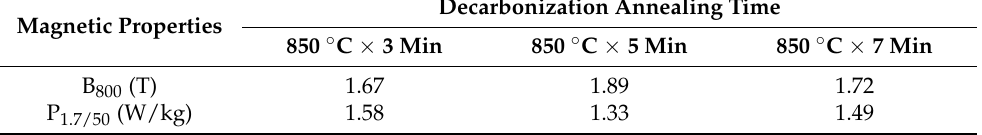
Table 4. Magnetic properties after high-temperature annealing with different decarbonization annealing times.